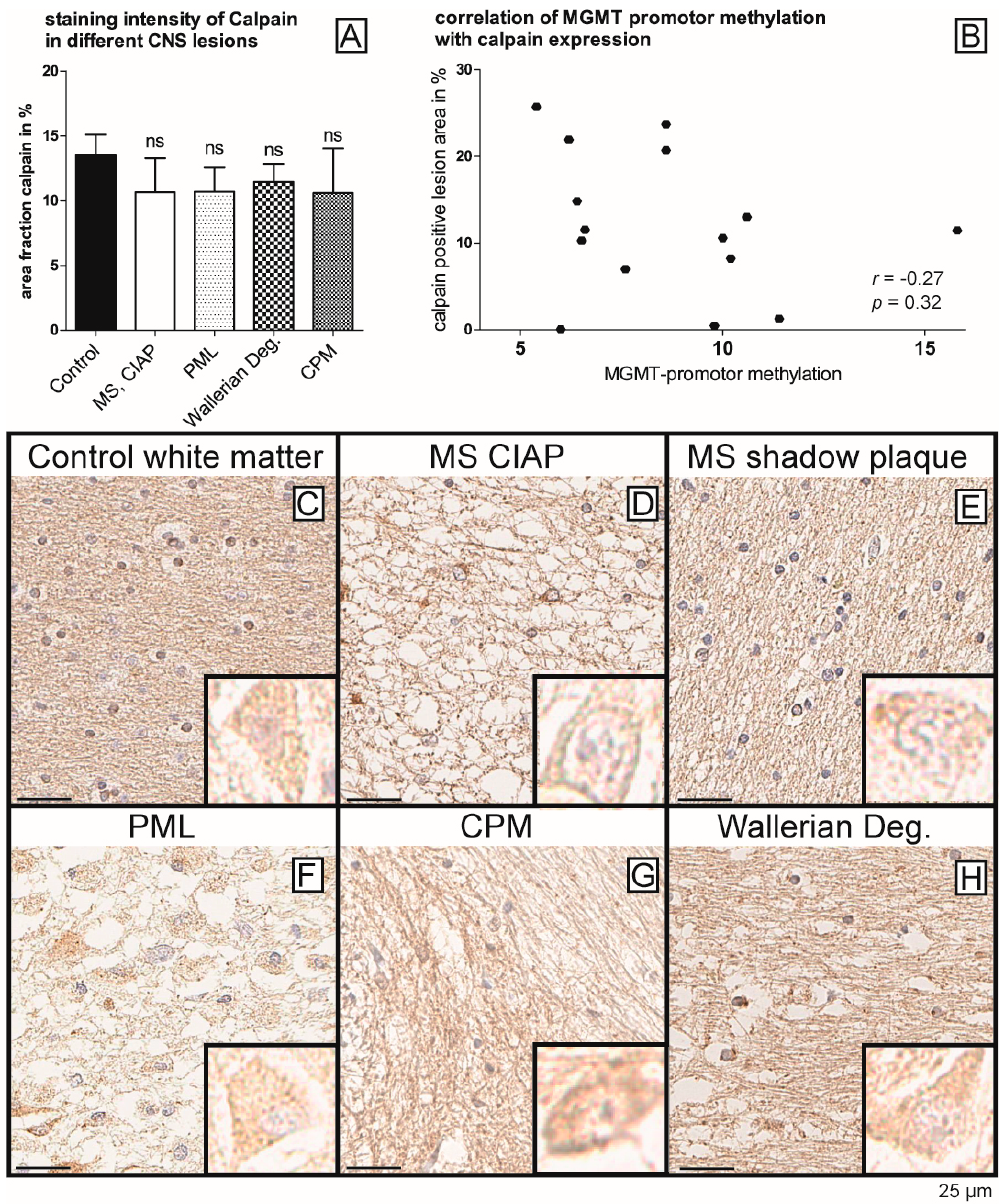
Figure 4. Calpain-1 staining of controls and samples with enhanced MGMT promoter methylation. Quantification ( A ) of Calpain-1 expression in glial cells reveals no significant differences in staining intensity between controls ( C ) and hypermethylated cases (MS—chronic inactive plaque ( D ); MS—shadow plaque ( E ); PML ( F ); CPM ( G ), or Wallerian degeneration ( H )), neither in glial cells nor in neurons (inset in ( C – H ), edge length 15 µ m each). Consequently, no correlations were found between Calpain-1 expression and MGMT methylation ( B ). Scale bar = 25 µ